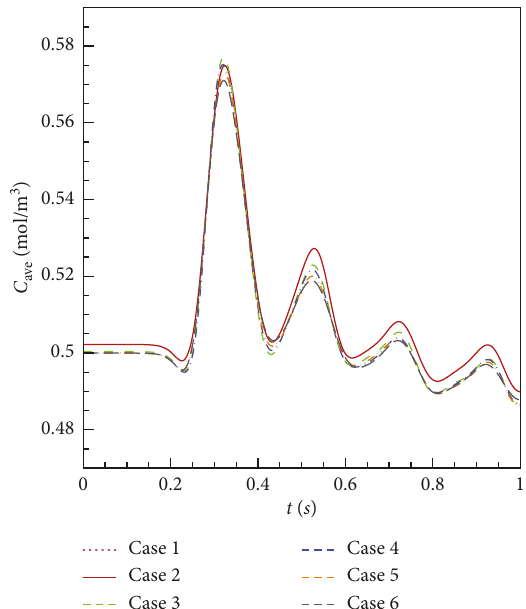
Figure 2: Changes in concentration with time plotted to test the solution’s grid